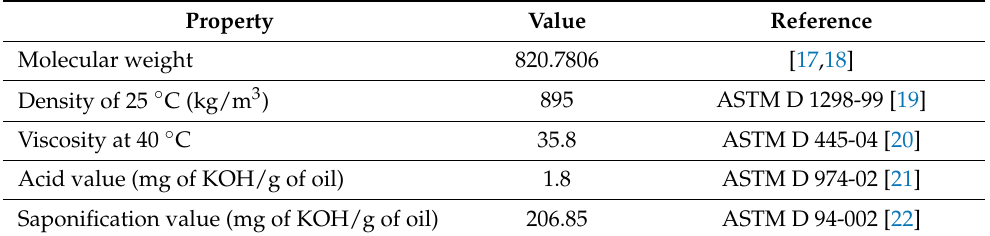
Table 2. Waste sunflower cooking oil physicochemical